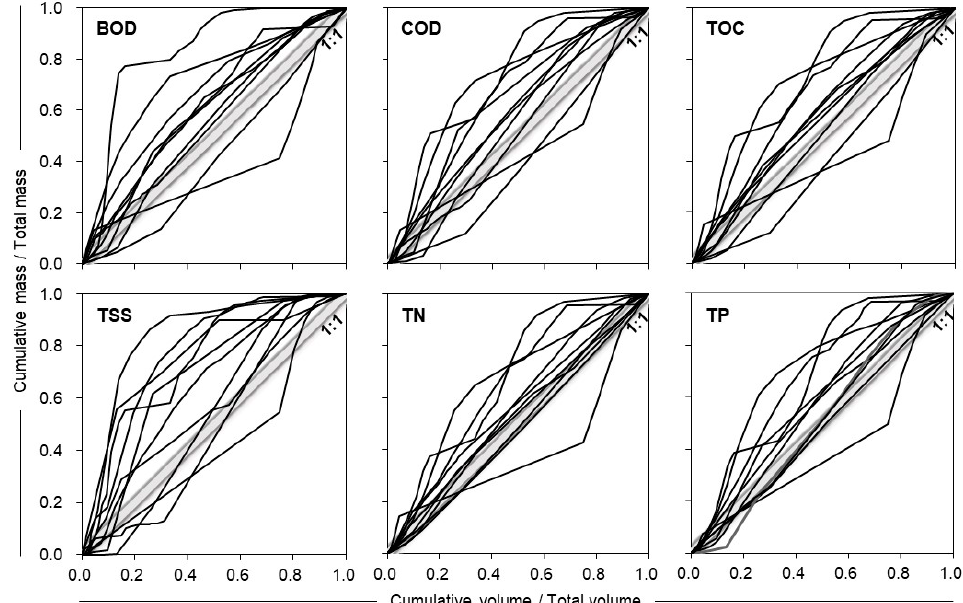
Figure 4. Cumulative load ratio for pollutant parameters in the immediate post-fire period. BOD: biological oxygen demand, COD: chemical oxygen demand, TOC: total organic carbon, TSS: total suspended solids, TN: total nitrogen, TP: total phosphorus. Table 2. Average cumulative load relative to cumulative runoff in spring and summer in the immediate post ‐ fire period.